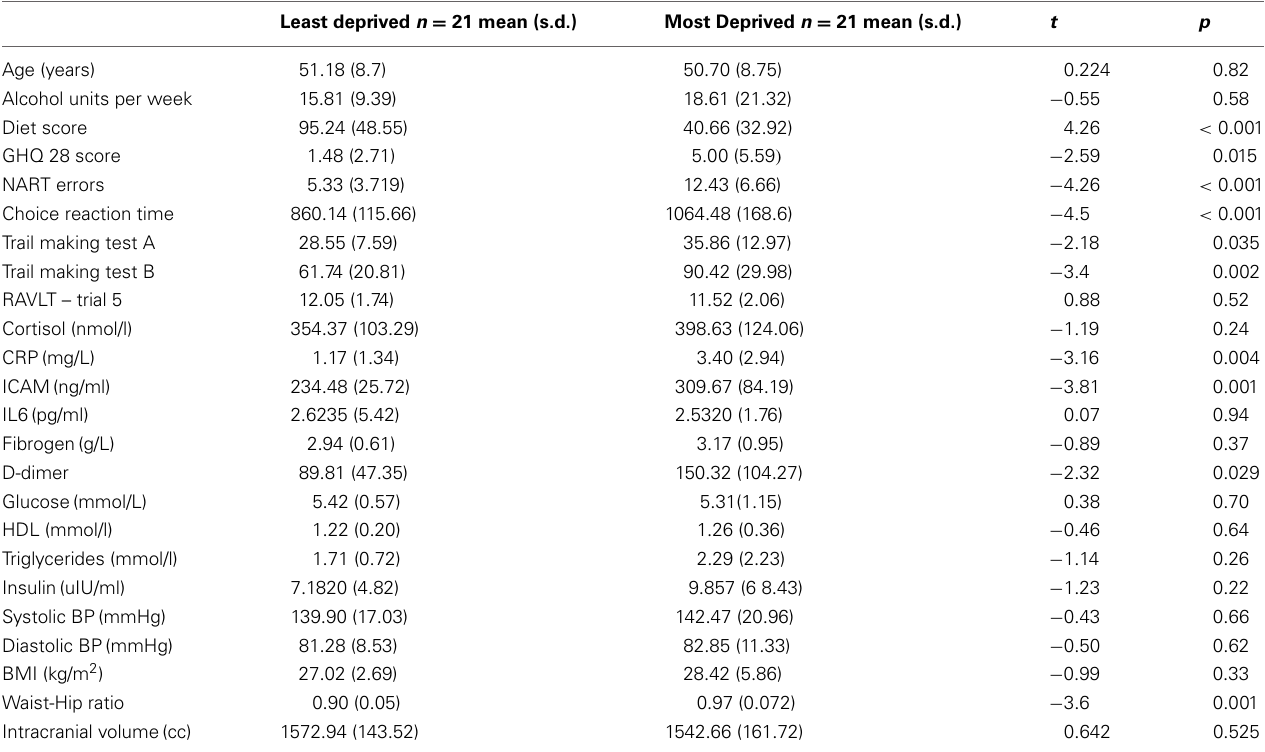
Table 1 | Demographic and clinical characteristics of study participants. Least deprived n = 21 mean (s.d.) Most Deprived n = 21 mean